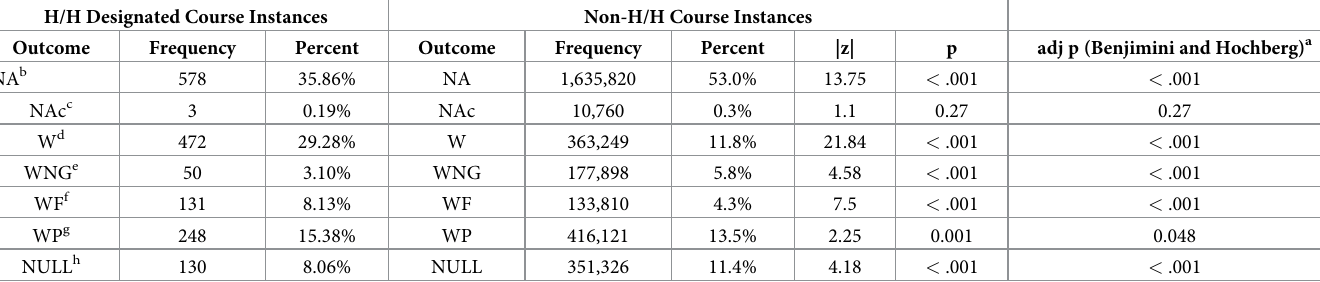
Table 4. Non-grade outcomes by course instance (H/H v non-H/H designated enrollments, 2012–2018).